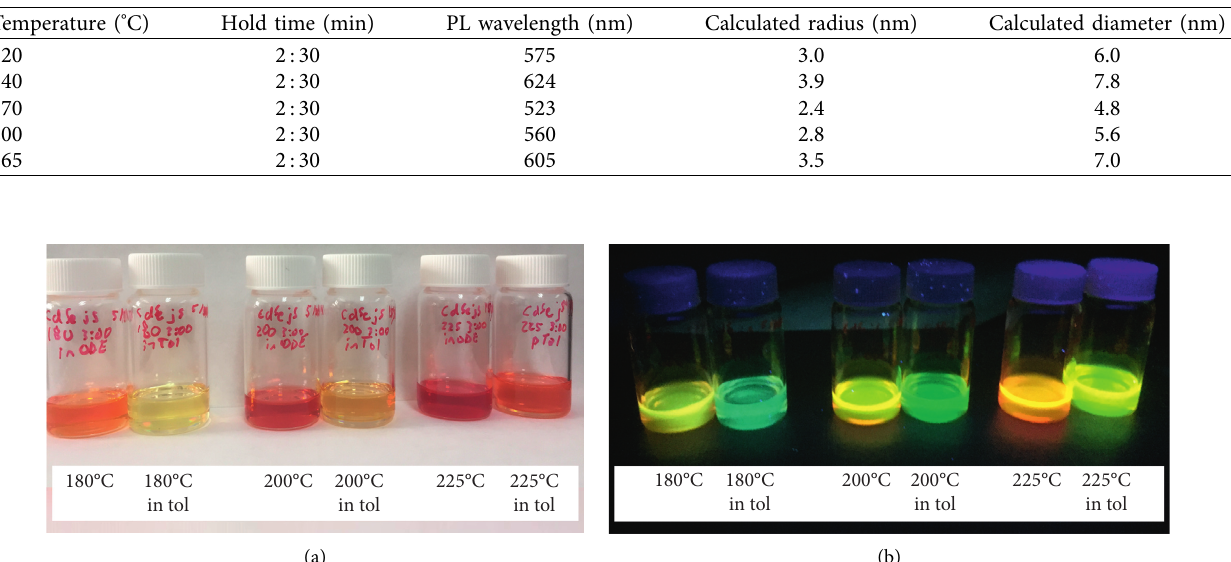
Table 1: Comparison of microwave parameters for synthesis of CdSe QDs and the calculated sizes of those QDs based on estimated peak PL wavelengths.